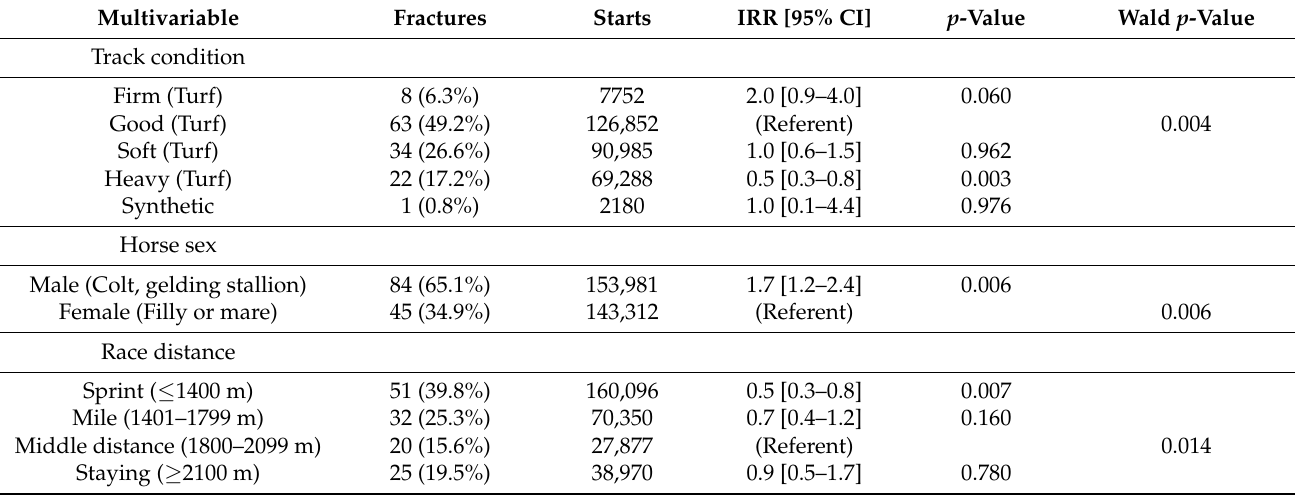
Table 4. Multivariable incidence rate ratios and 95% confidence of a fatal fracture occurring with the effects of track condition/ surface, horse sex and race distance for Thoroughbred flat racing in the 2011/12–2021/22